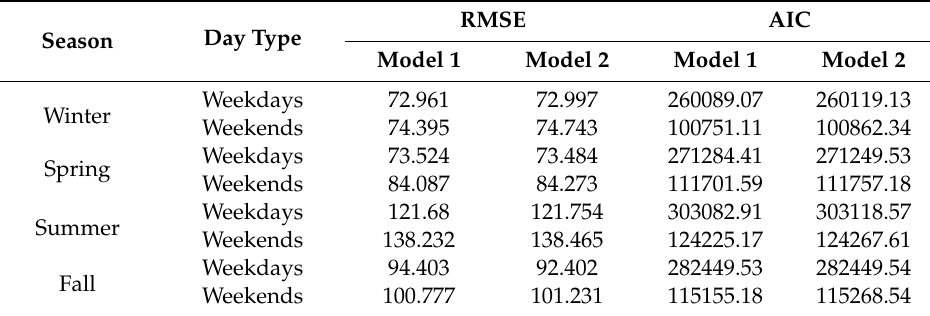
Table 2. The comparison between the two